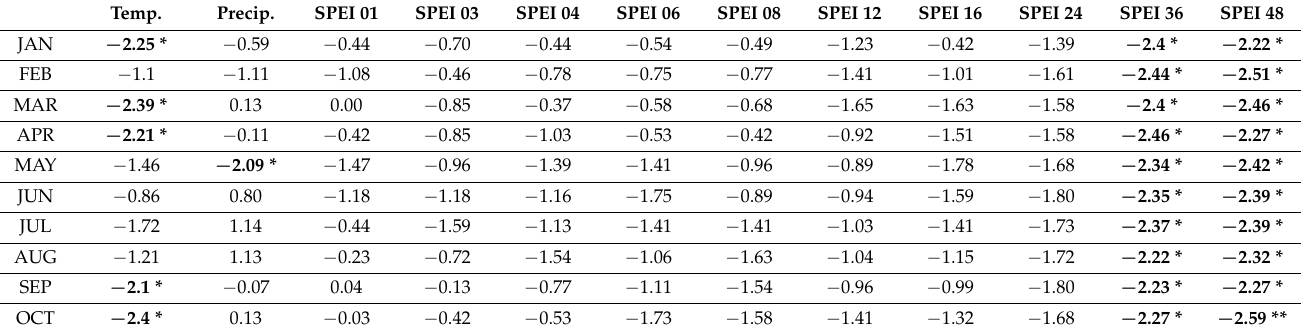
Table A1. Mann–Kendall statistics for precipitation, temperature, and drought (represented as SPEI 01 to SPEI 48) trends for the individual months (from January to December), short (i.e., A–S) and long (i.e., M–O) vegetation period, and for the whole year over the common period 1963–2011.